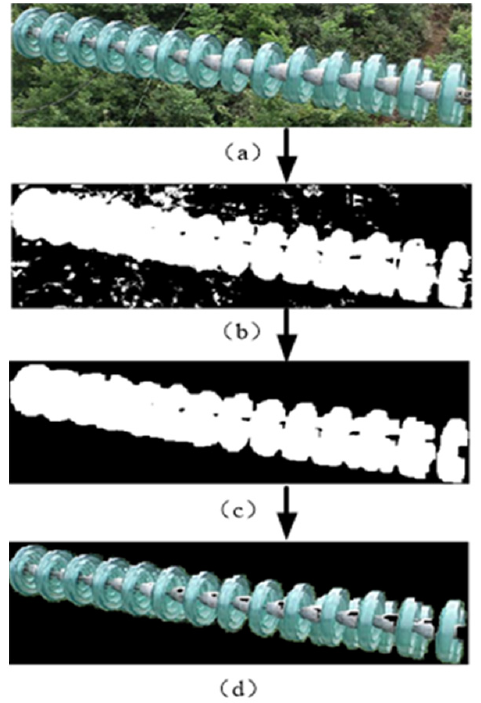
Figure 5. The process of removing the background from the insulator image: ( a ) Insulator target image, ( b ) Binary image, ( c ) Binary image after open operation, ( d ) Segmentation